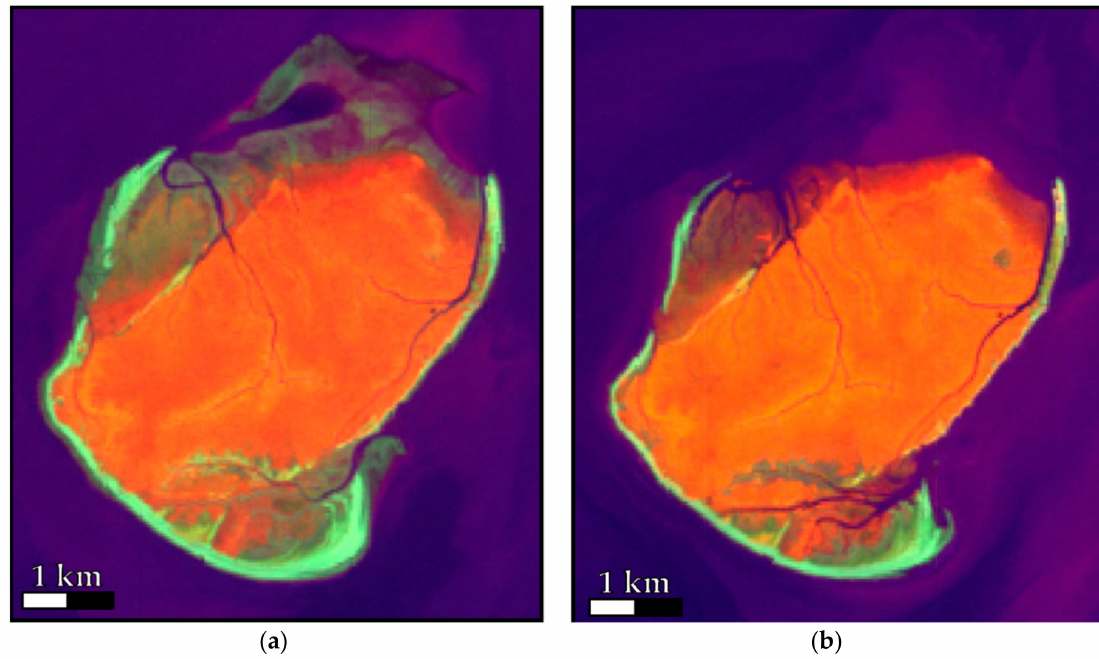
Figure 5. Examples of image composite outputs from the GEEMMM showing lowest observable tide (LOT), panel ( a ) and highest observable tide (HOT), panel ( b ). The north oriented, false colour (R: NIR G: SWIR B: Red) Landsat image is over Kaingthaung Island, Ayeyarwady Region,